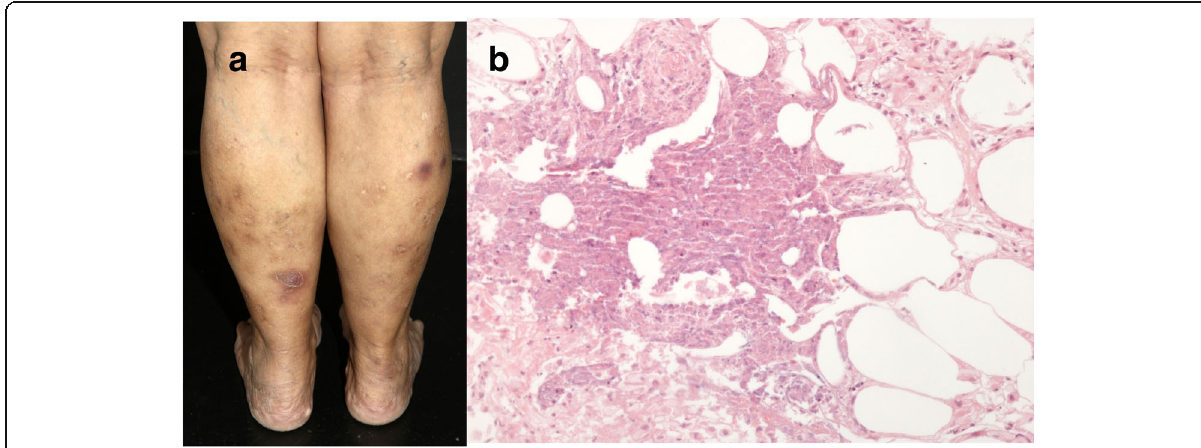
Fig. 8 Erythema induratum. a Erythematous nodules and atrophic scars in the legs. b Caseous necrosis in the lobules of the hypodermis. H&E,